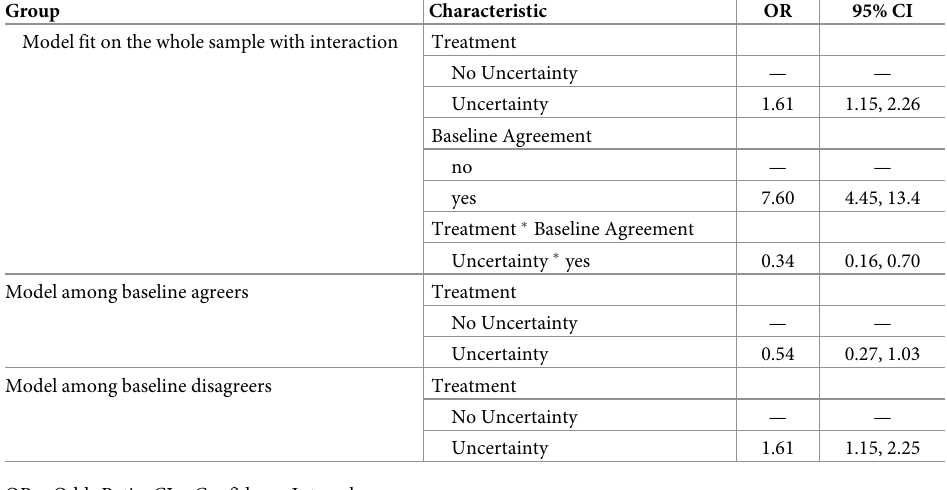
Table 2. Proportional odds model examining the impact of seeing uncertainty in the initial recommendation on accepting a future recommendation. Group